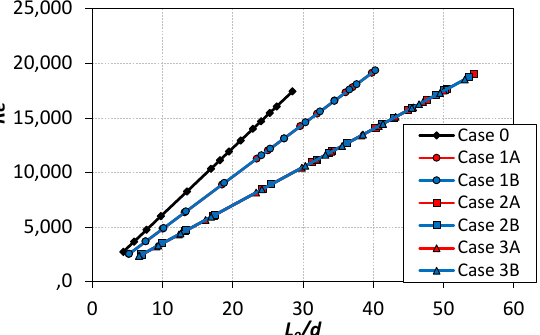
Figure 8. The dimensionless stroke length vs. the Reynolds number.